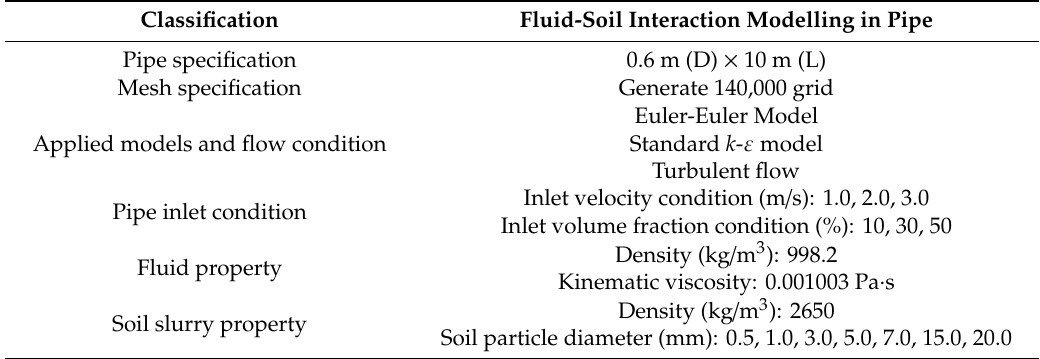
Table 1. Input and boundary conditions for the numerical analysis in this study.